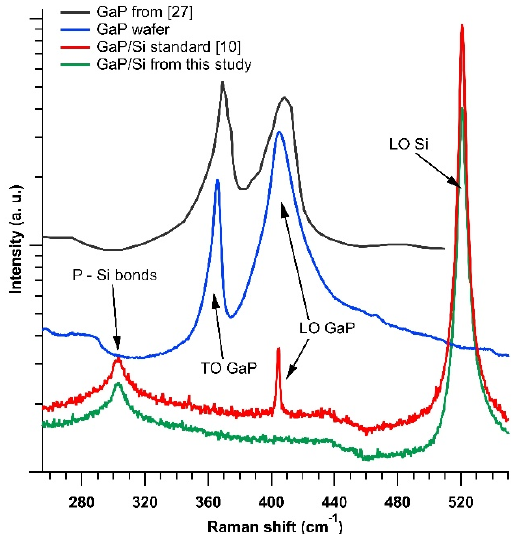
Figure 8. Raman spectroscopy of GaP samples. In black: GaP from [27]. In blue: bulk GaP. In red: GaP/Si template from [5]. In purple: GaP nucleated on Si under study.